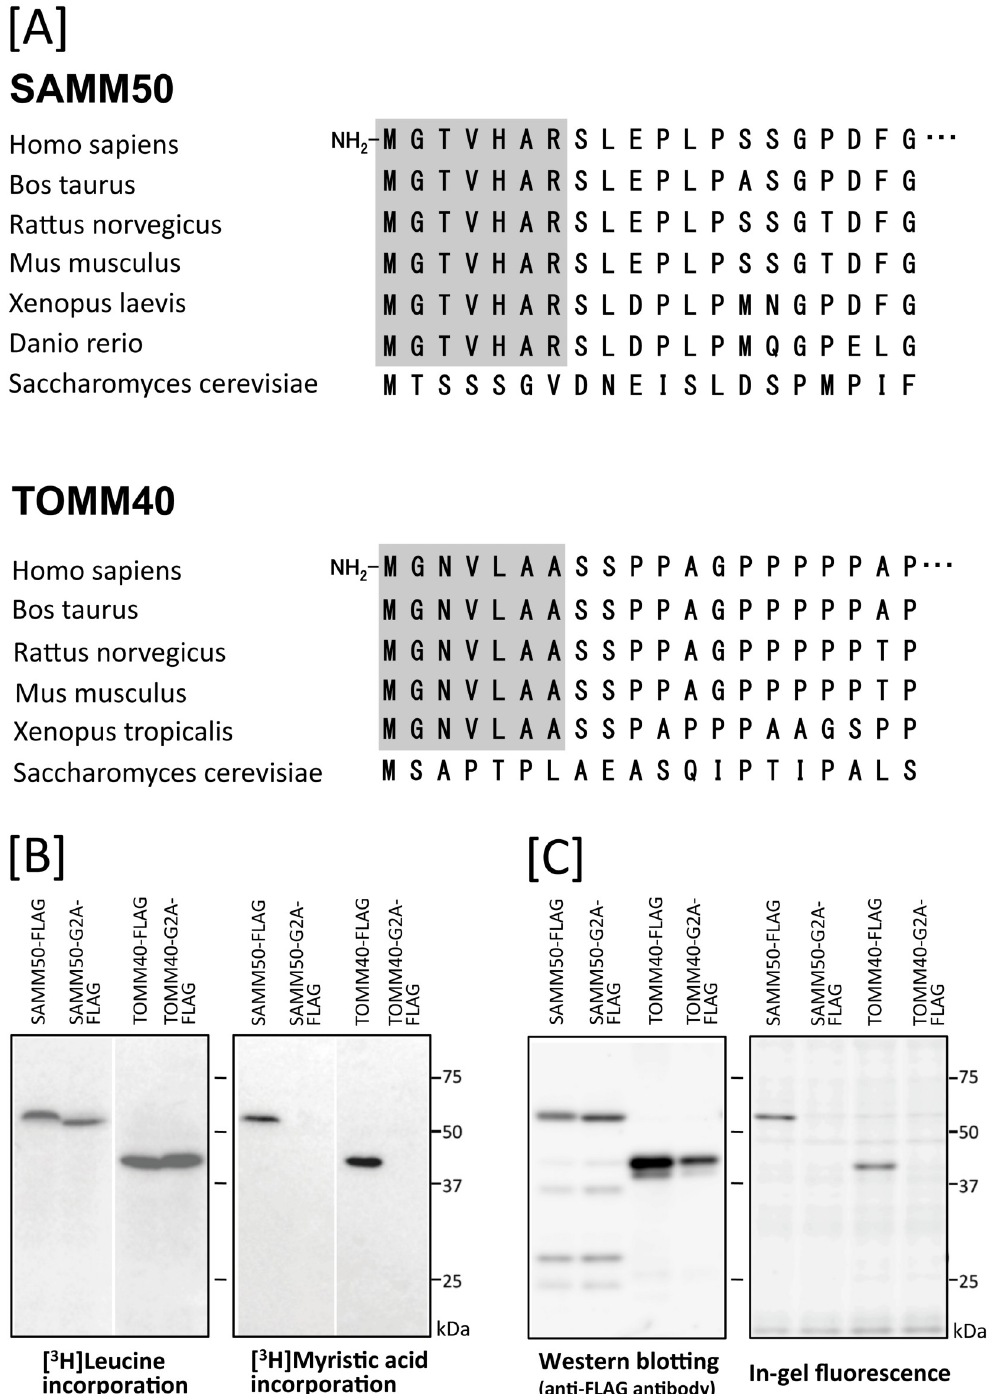
Fig 1. Detection of protein N -myristoylation of human SAMM50 and TOMM40 by cell-free and cellular metabolic labeling. A. Interspecies alignment of the N-terminal sequences of SAMM50 and TOMM40. N -myristoylation motifs are shown in grey in the N-terminal sequences. B. The gene products of cDNAs encoding SAMM50-FLAG, SAMM50-G2A-FLAG, TOMM40-FLAG, and TOMM40-G2A-FLAG were synthesized using an insect cell-free protein synthesis system in the presence of [ 3 H]leucine or [ 3 H]myristic acid. The labeled translation products were analyzed by SDS-PAGE and fluorography, as described in the Materials and methods. C. cDNAs encoding SAMM50-FLAG, SAMM50-G2A-FLAG, TOMM40-FLAG, and TOMM40-G2A-FLAG were transfected into COS-1 cells. The expression of